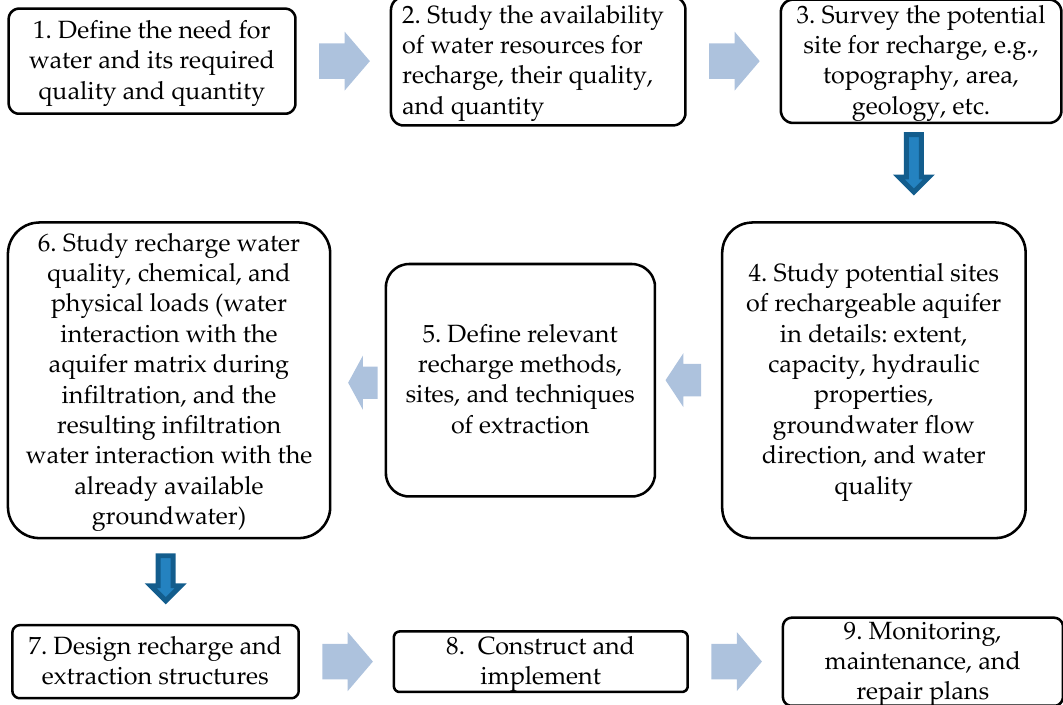
Figure 1. Flow chart of MAR design considerations.